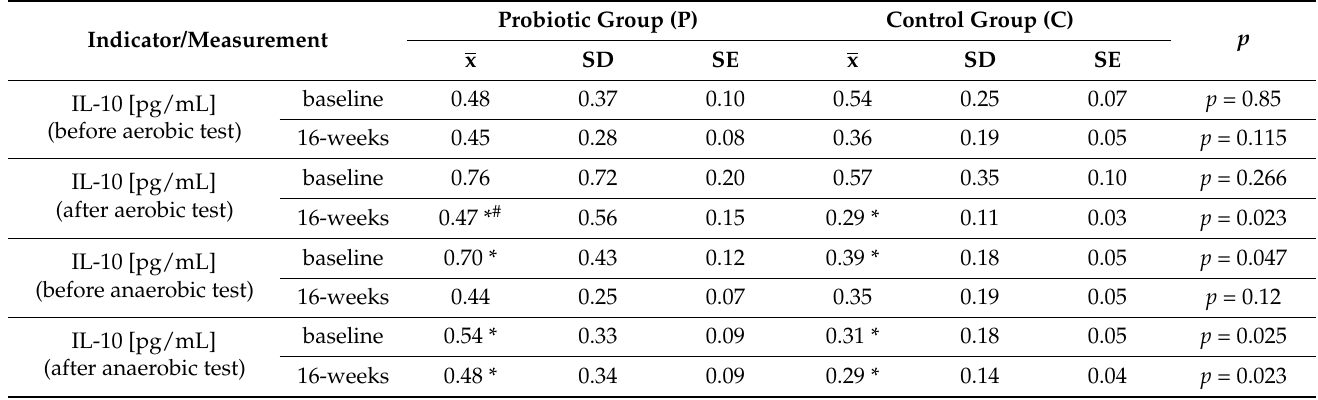
Table 12. The concentration of Interleukin 10 (IL-10) pre- and post-aerobic test and pre- and post- anaerobic test at follow-up measurements during supplementation intervention.